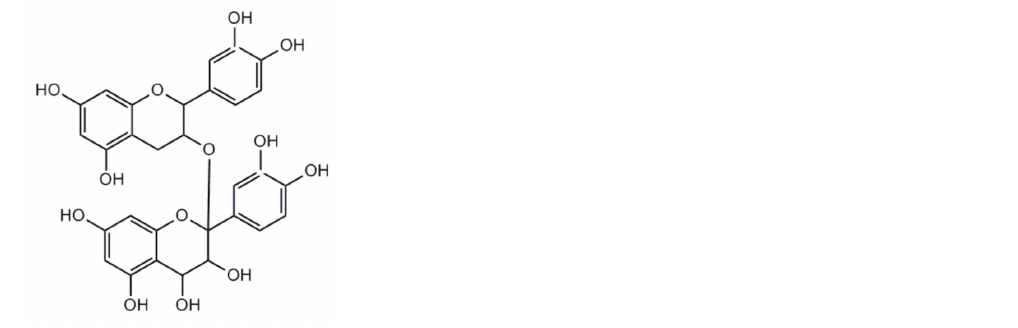
Figure 3. Structure of untypical proanthocyanidins isolated from fruits of Vitis vinifera used in the study of Huang et al.